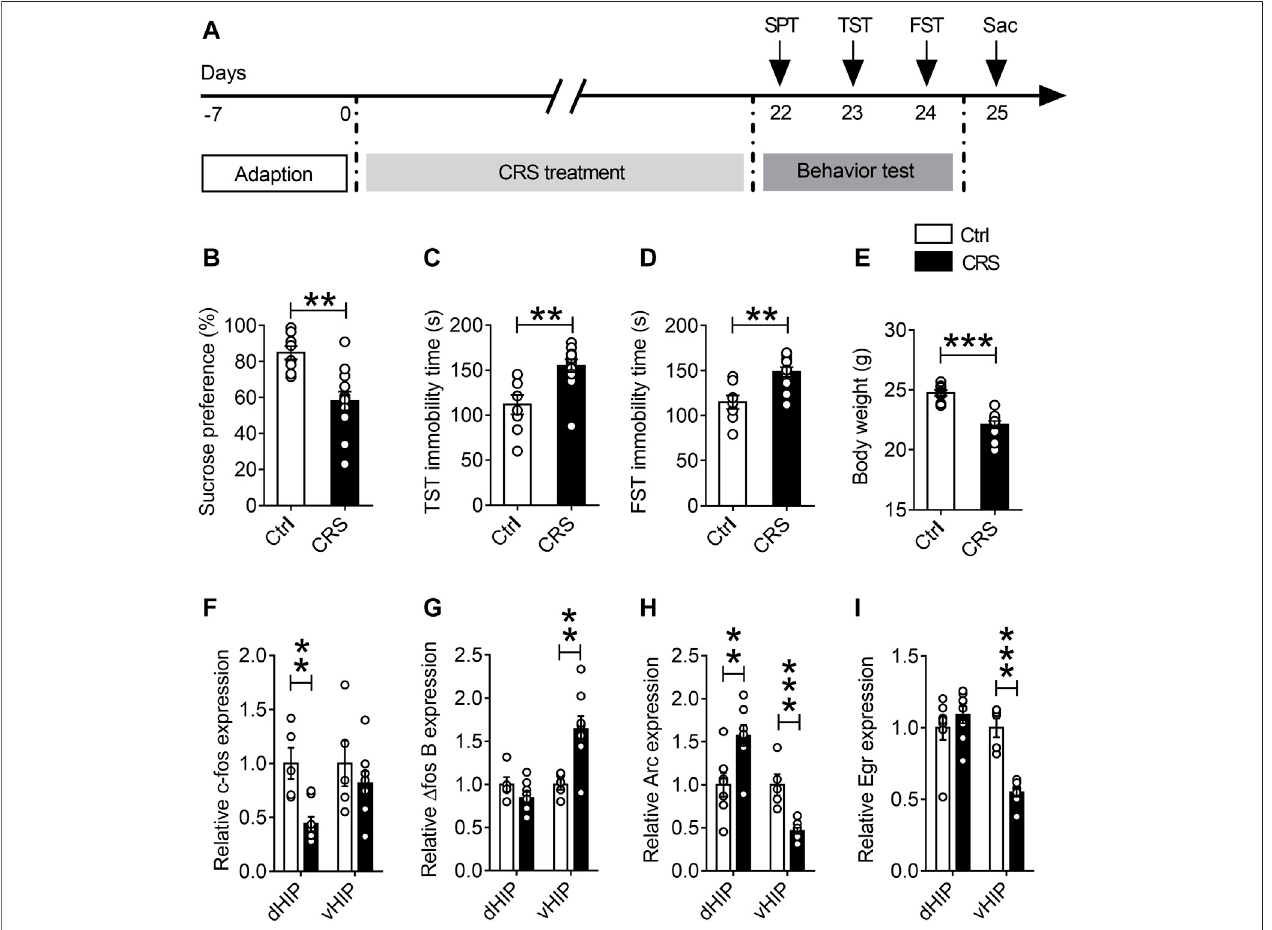
FIGURE 1 | Effects of CRS on dorsal and ventral hippocampal IEG expression. (A) The schematic timeline of the experimental procedures. (B – E) Mice that exposedtoCRSfor21 daysdisplayeddepression-likebehavior,includingreducedsucrosepreferenceintheSPT (B) ,increasedimmobiletimeintheTST (C) ,increased fl oating time in the FST (D) and weight loss compared with the controls (E) . (F – I) RT-qPCR assays found that the mRNA level of c-fos was selectively decreased in the dHIP, and not signi fi cantly changed in the vHIP (F) . The mRNA level of △ fos B was increased in the vHIP, without signi fi cant alteration in the dHIP (G) . The mRNA level of Arc was upregulated in the dHIP but downregulated in the vHIP (H) . The mRNA level of Egr was reduced in both the dHIP and vHIP (I) . Data are presented as mean ± SEM. One-way ANOVA for all. n (cid:1) 8-12 per group for (B – E) ; n (cid:1) 5 – 7 per group for (F – I) . ** p < 0.01, *** p < 0.001 vs. Ctrl group.